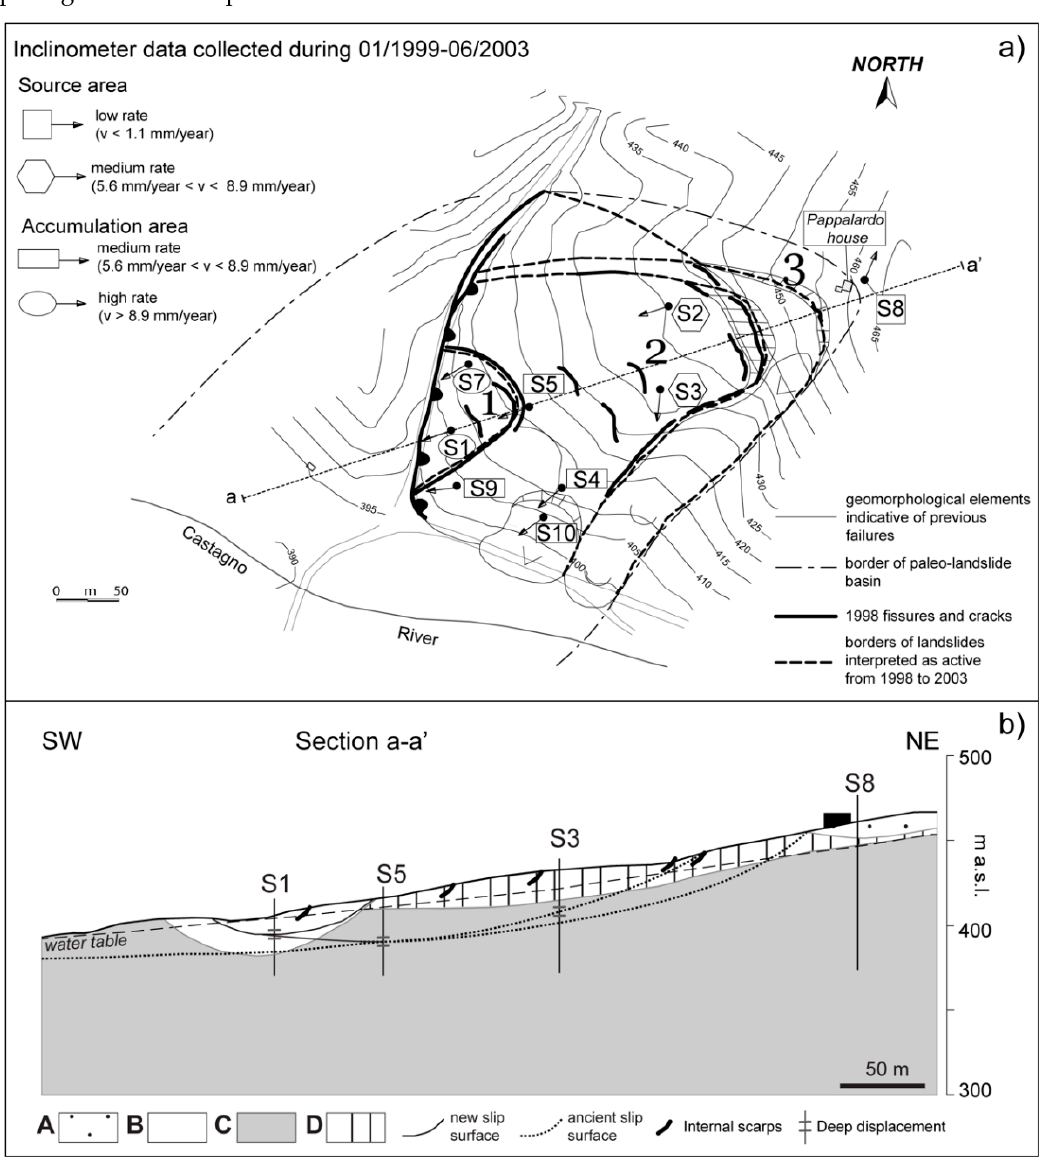
Figure 7. Geomorphological map ( a ) and section ( b ) of the Tolve slope (adapted from [60]); Key. Soil complexes: yellow sands ( A ), remoulded clays ( B ), sub-Apennine Clays ( C ), weathered clays ( D ).